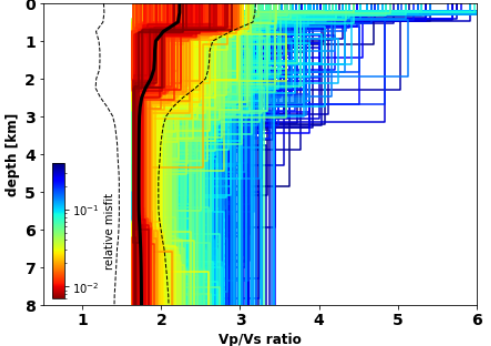
Figure 11. Vp/Vs ratio (thick black line), obtained from the final Vp and Vs models (black curves in Figure 9A,B), as a function of depth. Dashed lines identify the confidence interval, defined as in Figure 10. Full distribution of sampled models with the lowest misfit are shown in